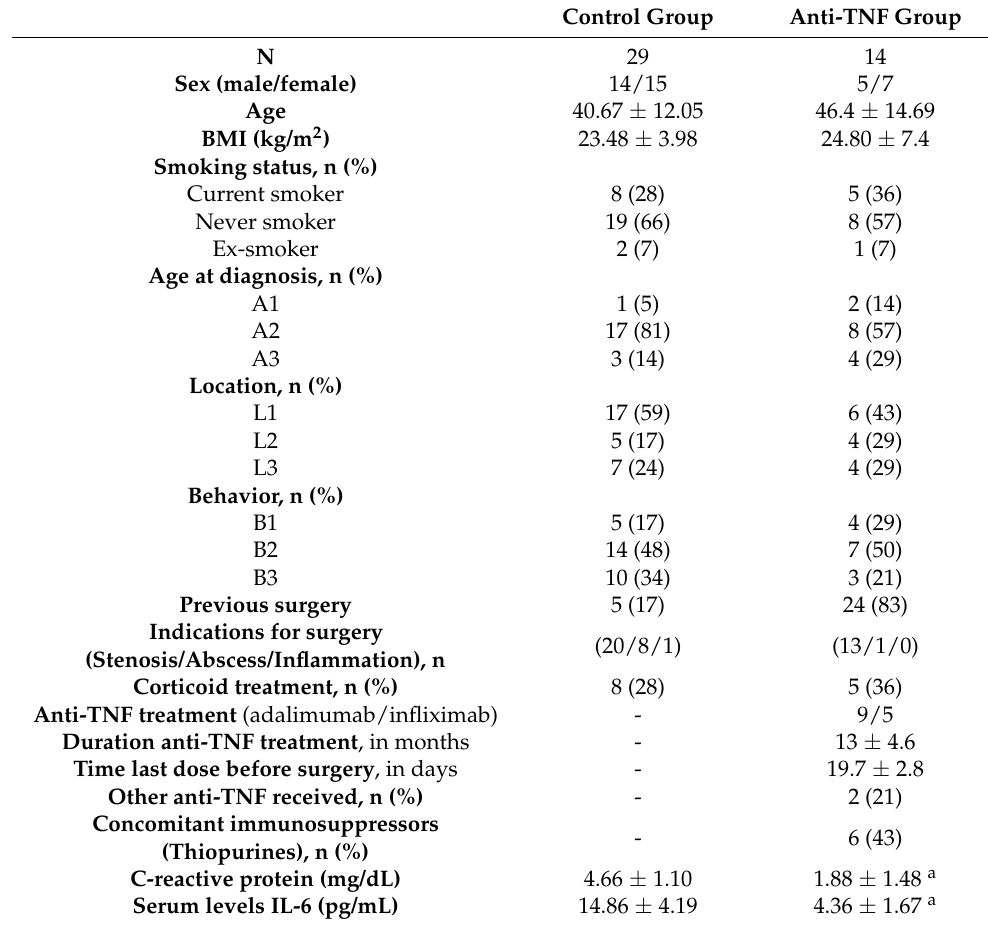
Table 1. Demographic characteristics and clinical data of